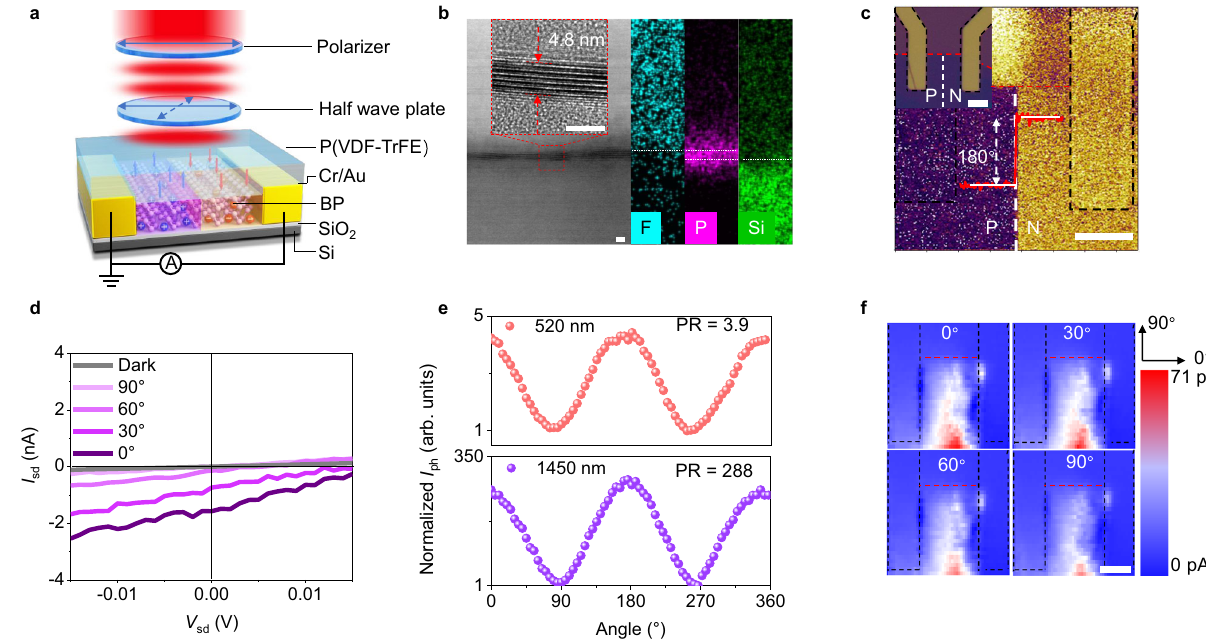
Fig. 3 BP in-plane PN homojunction photodetector with ultrahigh polarization sensitivity. a Schematic of BP in-plane PN homojunction de fi ned by ferroelectric domains. b High-resolution transmission electron microscopy (HR-TEM) image and energy-dispersive X-ray spectroscopy (EDS) elemental mapping of F, P and Si. The inset is the partial enlarged drawing HR-TEM image and the thickness of BP is 4.8 nm. Scale bar is 5 μ m. c The PFM phase image of the device. The phase difference between p-doped (P) region and n-doped (N) region is 180°. The inset shows corresponding optical image. The black dashed lines indicate the electrodes, the red dashed lines indicate the edge of BP material and the white dashed lines indicate the boundary of P and N region. Scale bar is 5 μ m. d I sd – V sd curves in the dark and under light of different incident polarization angle ( λ = 1450 nm, P eff = 10 μ W). e Normalized photocurrent of the BP in-plane PN homojunction as a function of the polarization angle. The unity corresponds to photocurrent when angle is 90° or 270° at 520nm (10 μ W) and 1450 nm (10 μ W). Polarizatio ratio (PR) is de fi ned as the ratio of maximum and minimum polarization-dependent photoresponse. f the spatial photocurrent map is obtained by scanning a 520 nm light beam with power 1 μ W and spot size 1 μ m. Scale bar is 5 μ